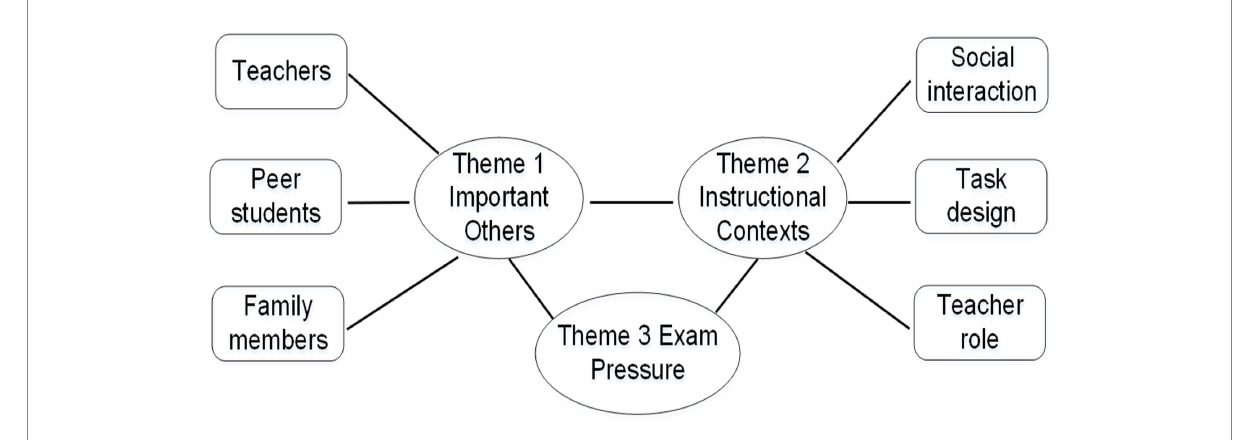
FIGURE 2 Thematic map of the influencing